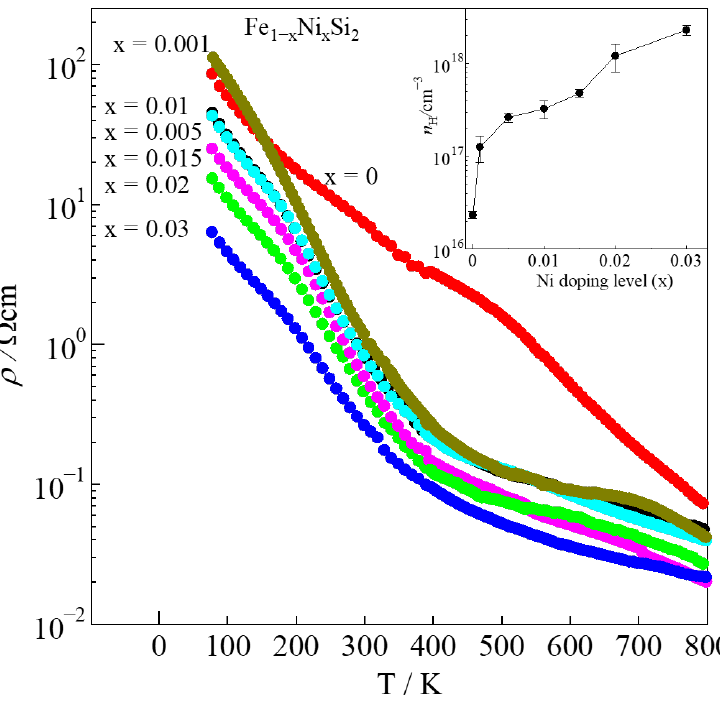
Figure 5. Electrical resistivity of β -Fe 1−x Ni x Si 2 (0 ≤ x ≤ 0.03) with respect to temperature, where the carrier concentration, n H , at 300 K is plotted in the inset.